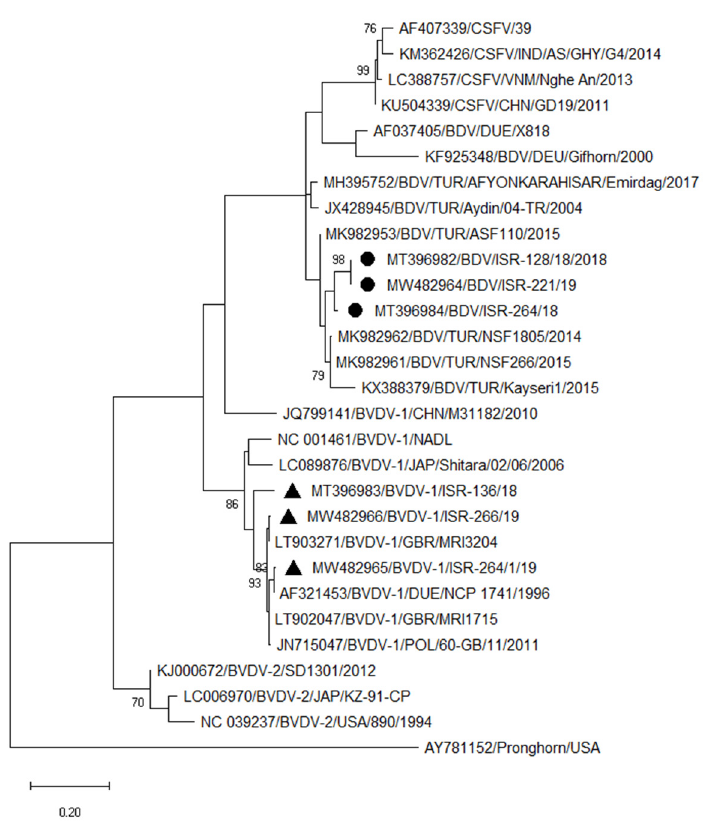
Figure 3. Phylogenetic analyses based on 5 ′ UTR sequences of pestiviruses. The virus species BVDV- 1 ( Pestivirus A ), BVDV-2 ( Pestivirus B ) and BDV ( Pestivirus D ) are included, pronghorn antelope pestivirus ( Pestivirus E ) is used as an outgroup. The sequences obtained from NCBI GenBank for comparison are labelled by accession number/virus species/location/isolate/year (when all data is available in GenBank or the corresponding publications). BVDV sequences generated in the present study are marked by black triangles and BDV sequences by black dots. Nucleotide sequences were analyzed using the maximum likelihood method and Kimura 2-parameter model. Statistical support for nodes was obtained by bootstrapping (1000 replicates); only values ≥ 70 % are shown. Scale bars indicate nucleotide substitutions per site.